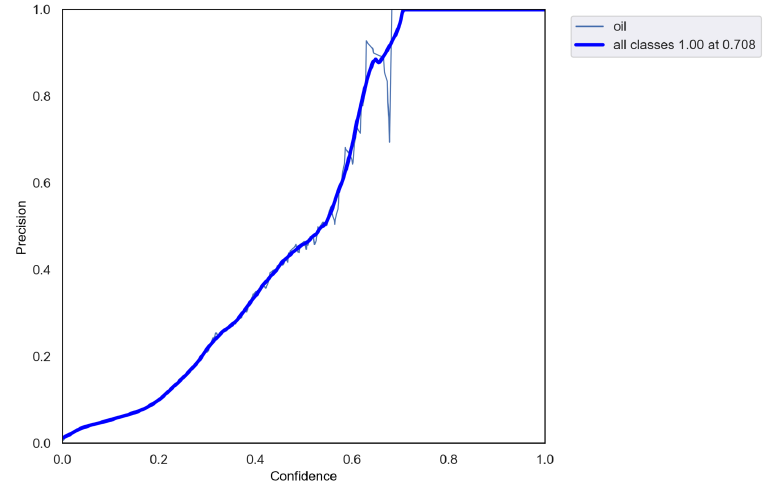
Figure 9. The precise–con fi dence curve.